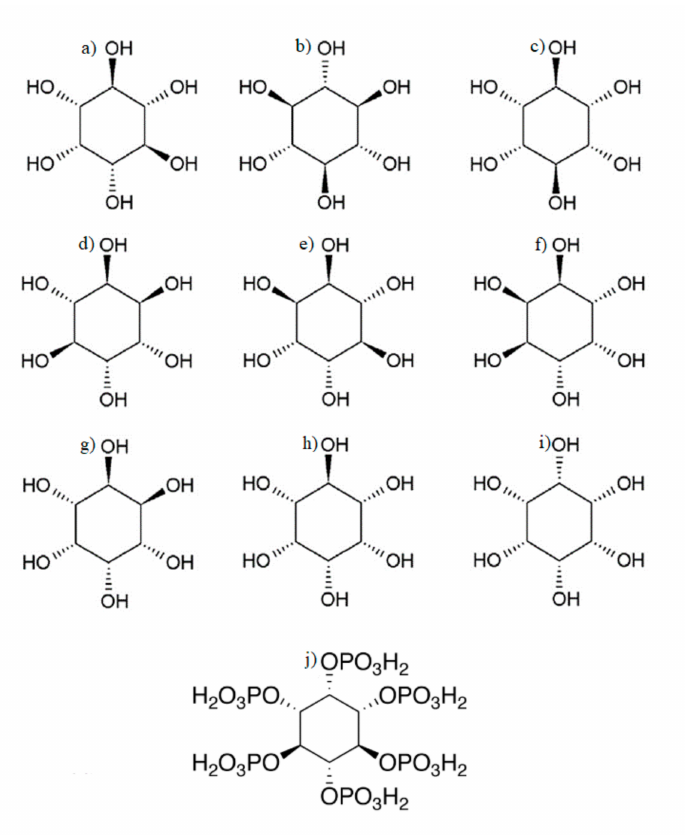
Figure 1. Structural formulas of ( a ) myo-inositol (MI); ( b ) scyllo-inositols (Ins); ( c ) mucco-Ins; ( d ) D-chiro-Ins; ( e ) L-chiro-Ins; ( f ) neo-Ins; ( g ) allo-Ins; ( h ) epi-Ins; ( i ) cis-Ins; and ( j ) phytic acid